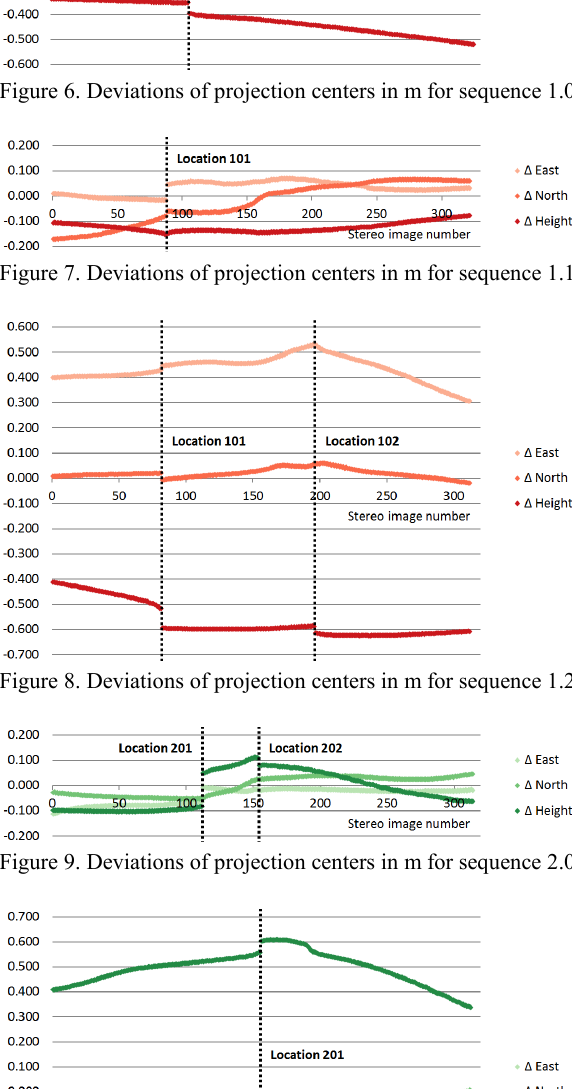
Figure 12. Deviations of projection centers in m for sequence 3.0